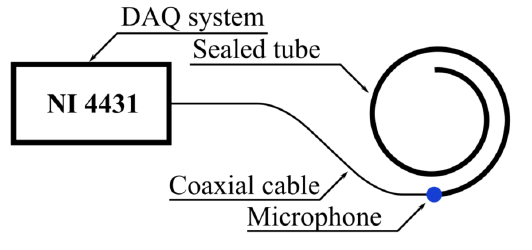
Figure 4. Diagram of the pneumatic